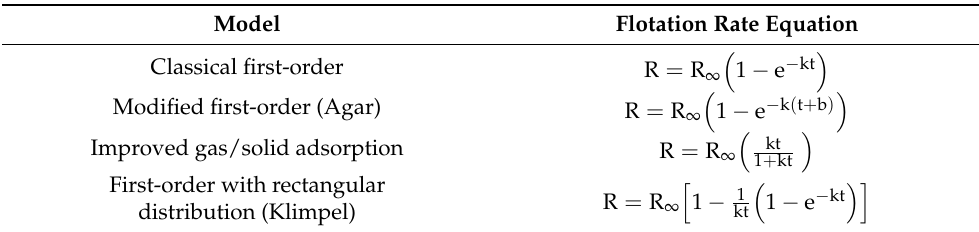
Table 1. Selected flotation kinetics